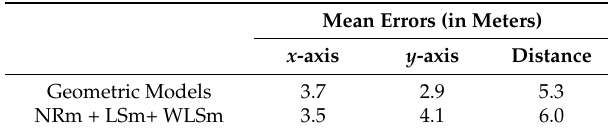
Table 2. Global mean errors (Geometric Models × Numerical Methods).